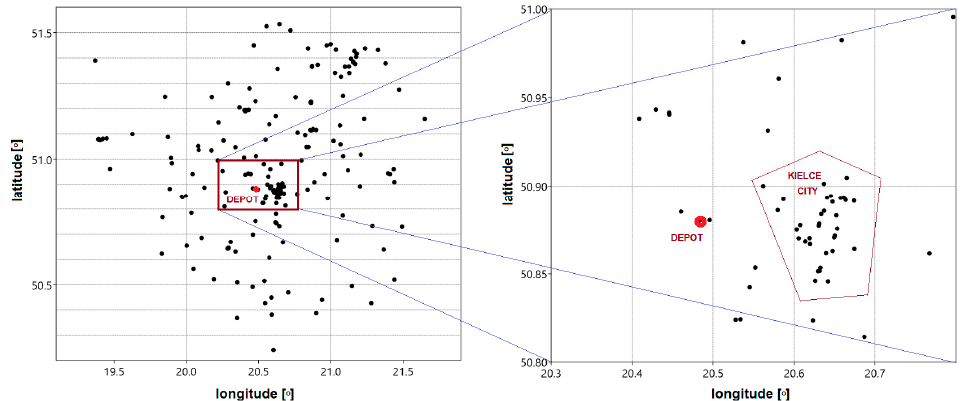
Figure 2. Location of destinations in geographical coordinates.